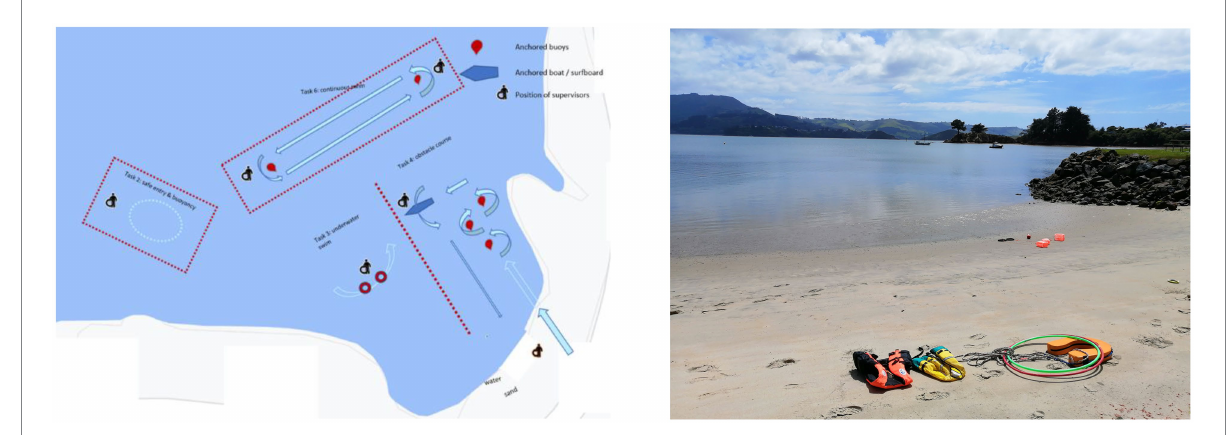
FIGURE 2 Experimental set-up for the outdoor testing sessions of the study. Left: Plan of the setup. Right: Overview of the beach testing